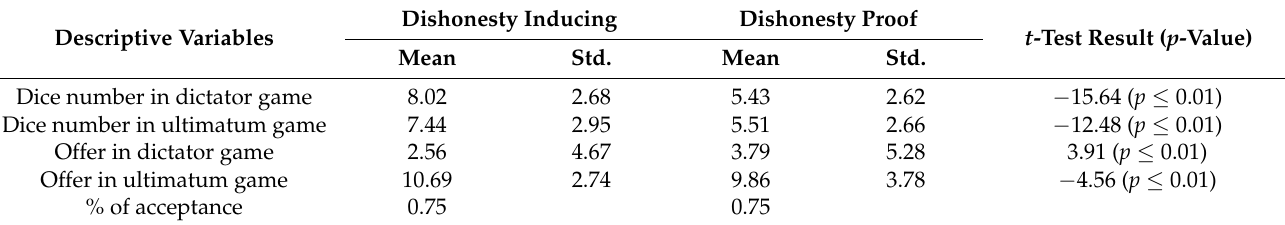
Table 1. Descriptive analyses results for two